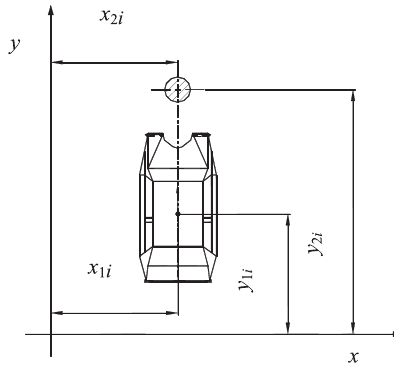
Fig. 6. Scheme of central car collision with a tree, a bollard,